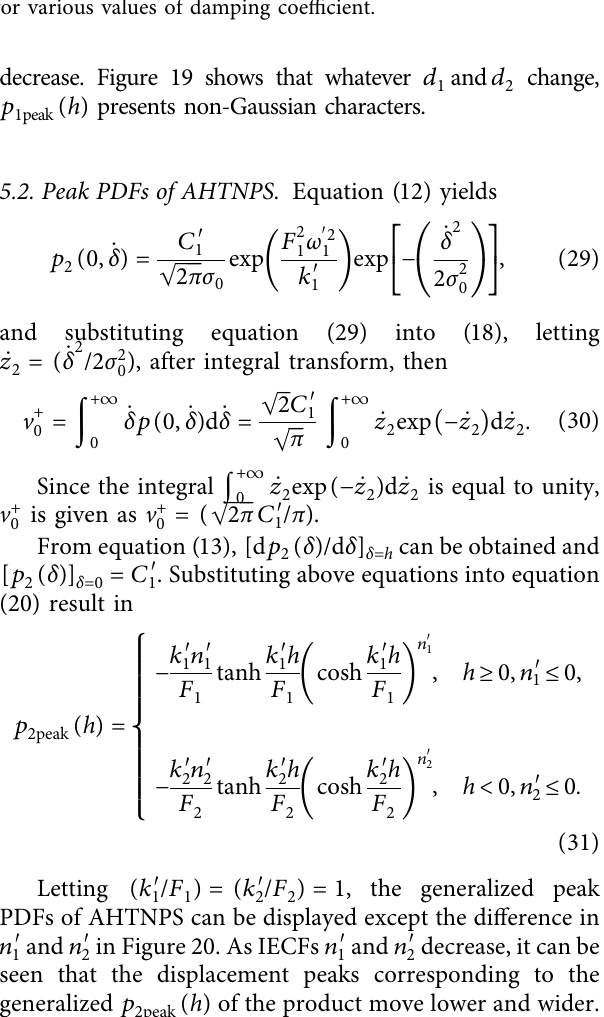
Figure 16: Displacement PDFs of ATHNPS for various values of damping